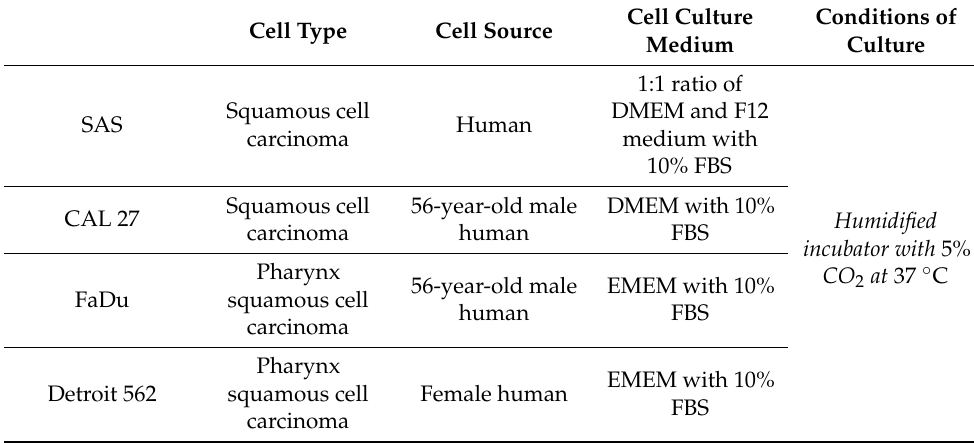
Table 1. The cell type, source, culture and conditions of the